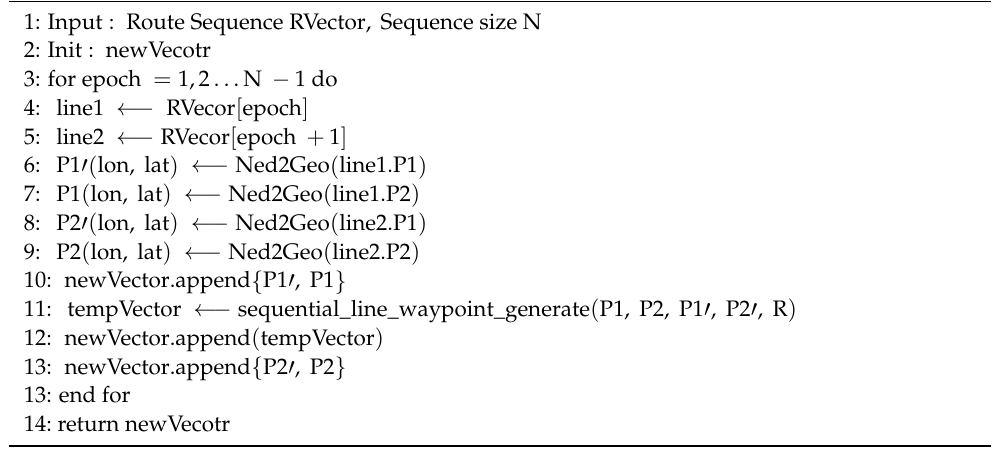
Algorithm 1. waypoint_generate.